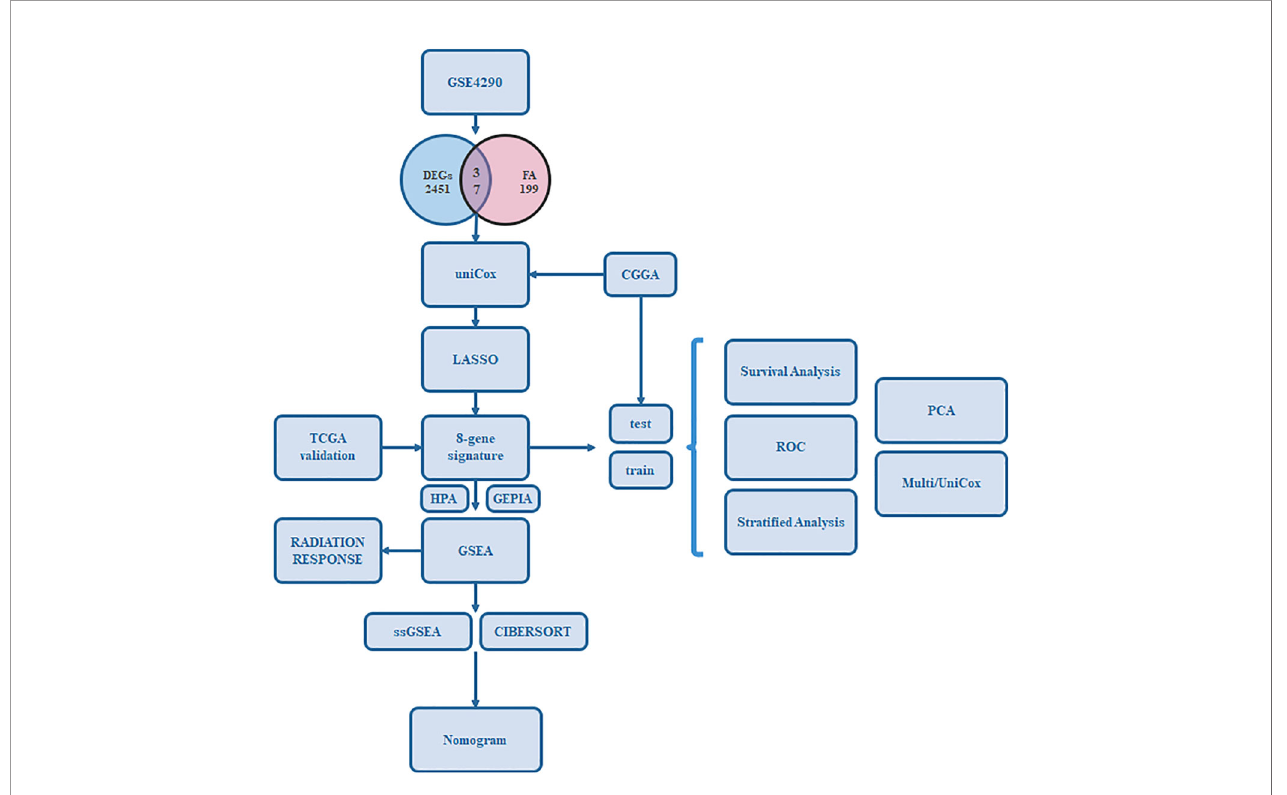
FIGURE 1 | Flow chart of our study.